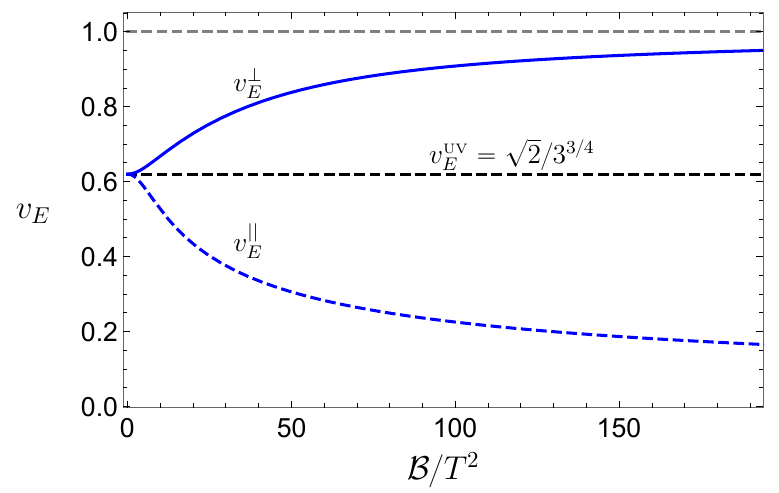
Figure 10 . Entanglement velocity v E versus the entanglement velocity for an orthogonal (parallel) strip, while the bottom horizontal black line represent the entanglement velocity at the UV (cid:12)xed point, which is equal to the conformal result v UV = p 2 = 3 3 = 4 . The top horizontal gray line is the speed of light. E ~(cid:16) ( ~ T ) =T can in principle induce a heat or electric current in any direction. The (cid:17) r